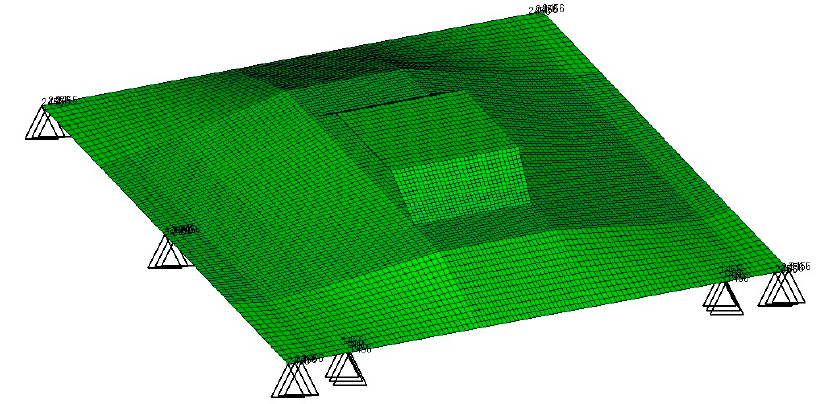
Figure 6. FEA model of spacer